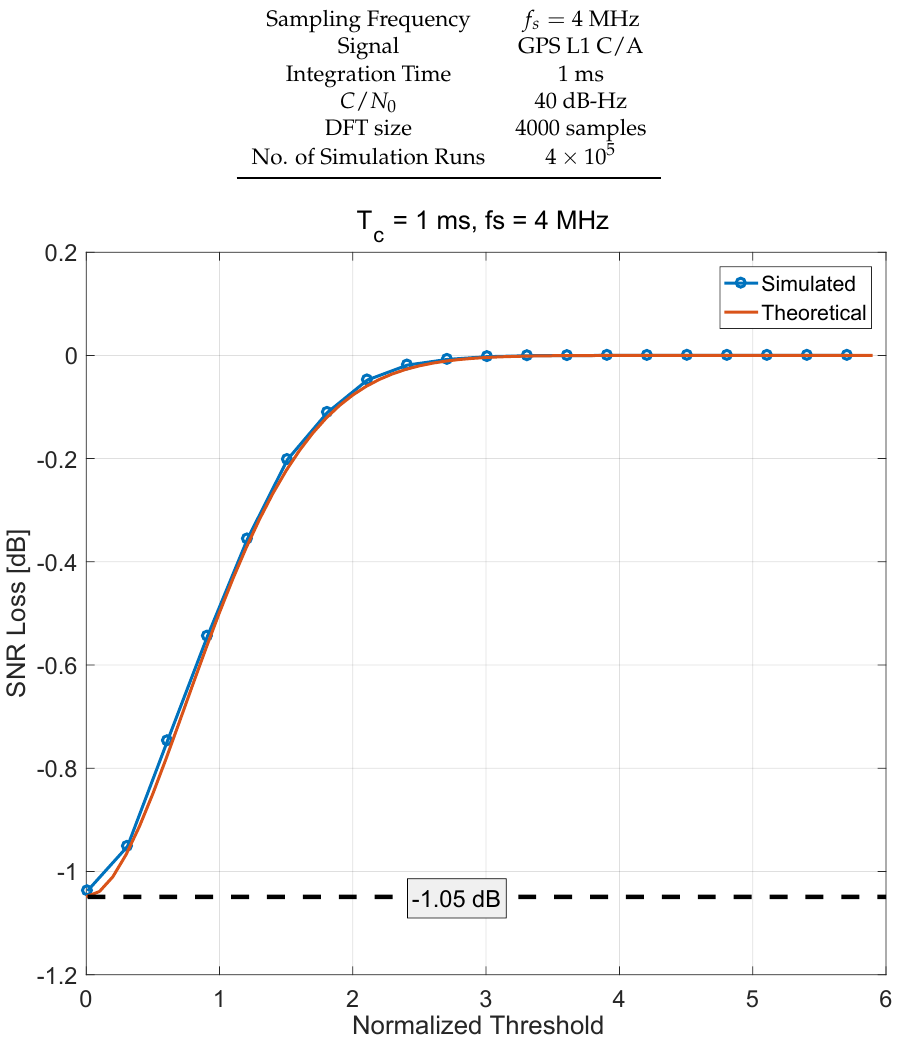
Figure 3. Loss of efficiency as a function of the normalized threshold, T h theoretical and simulation results. Results obtained considering frequency domain